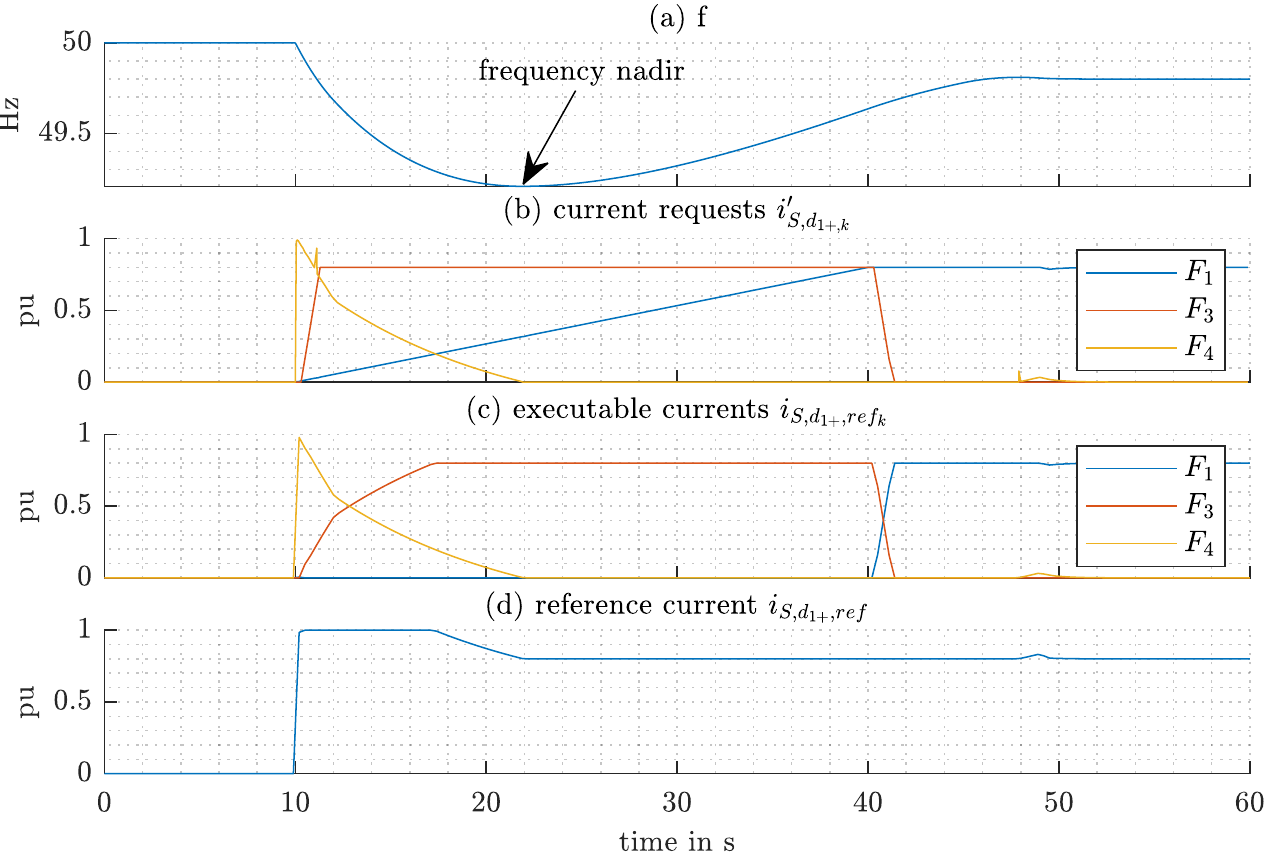
Figure 8. Dynamic prioritization during reference